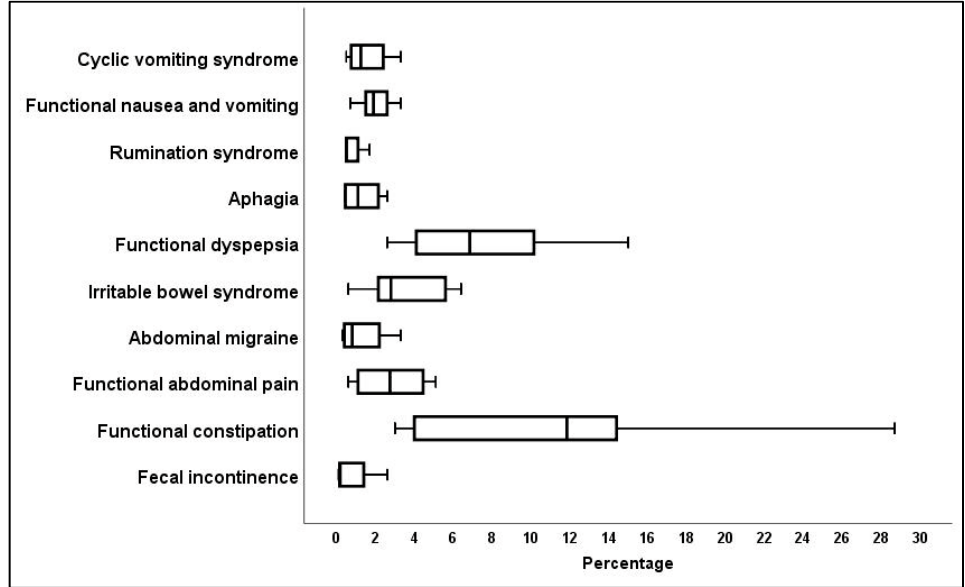
Figure 2. Percentage incidence of specific Rome IV criteria for children over the age of four